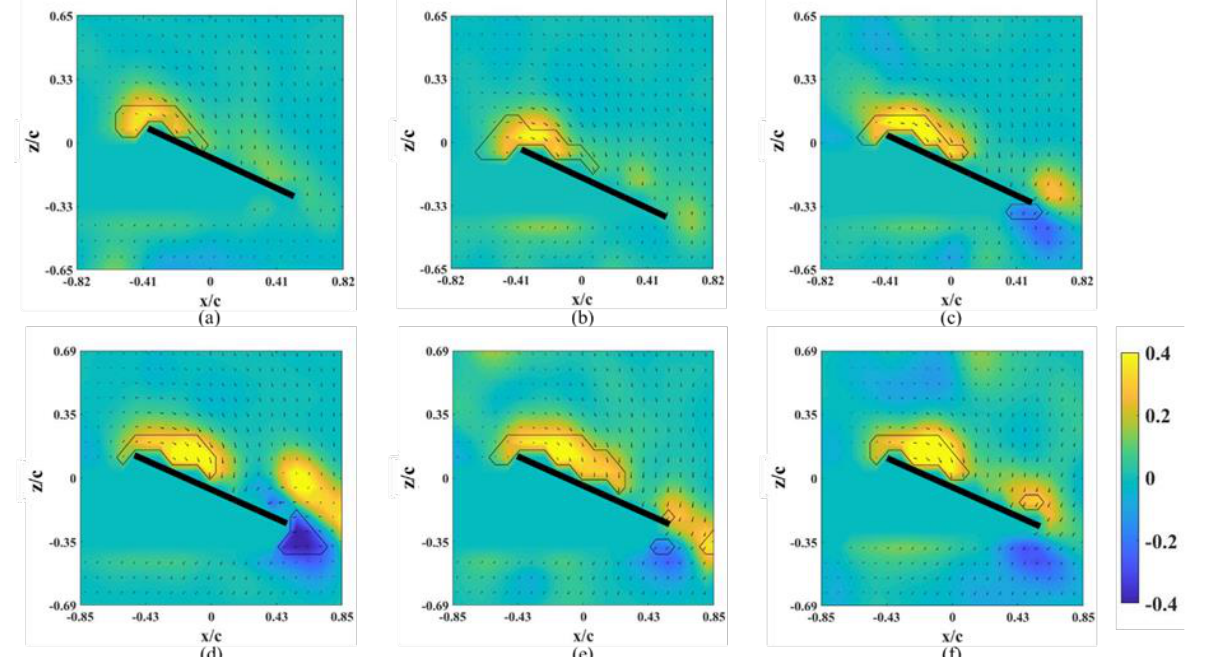
Figure 4. Vorticity contours around the base wing model without alula-VG on different x-z planes at α = 25°. ( a ) r * = 0.36, ( b ) r * = 0.46, ( c ) r * = 0.56, ( d ) r * = 0.66, ( e ) r * = 0.76, and ( f ) r * = 0.8.